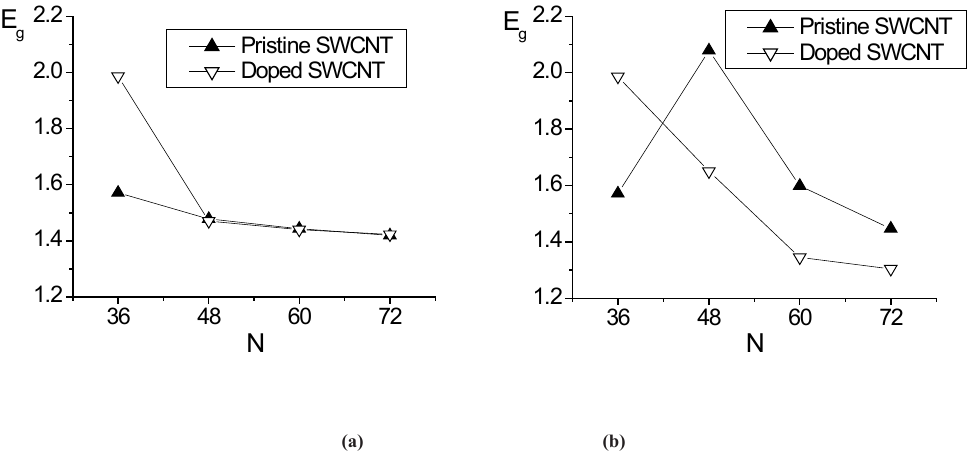
Figure 1. Dependence of the energy gaps (E ) at B3LYP/6-31G(d,p) level on the total number (N) of atoms in the SWCNTs, N was increased by g (a) Radial enlargement and (b) Elongation in